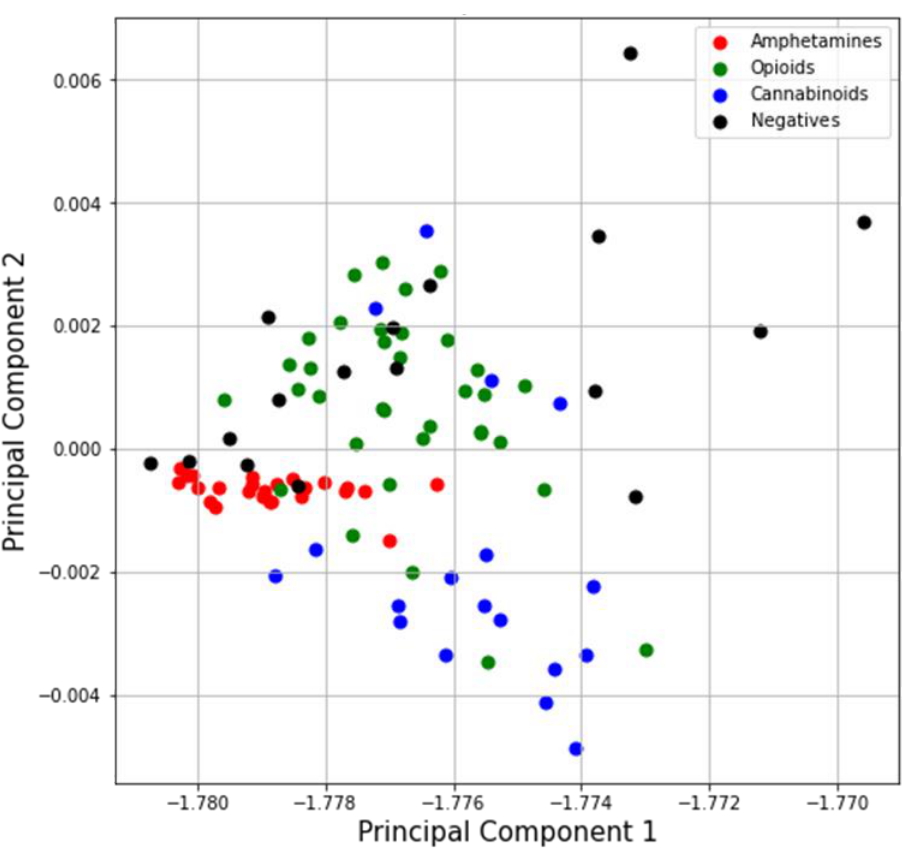
Figure 2. Score plot of the first two principal components of a two-component PCA displaying the class of amphetamines (red), opioids (green), cannabinoids (blue), and negatives (black).